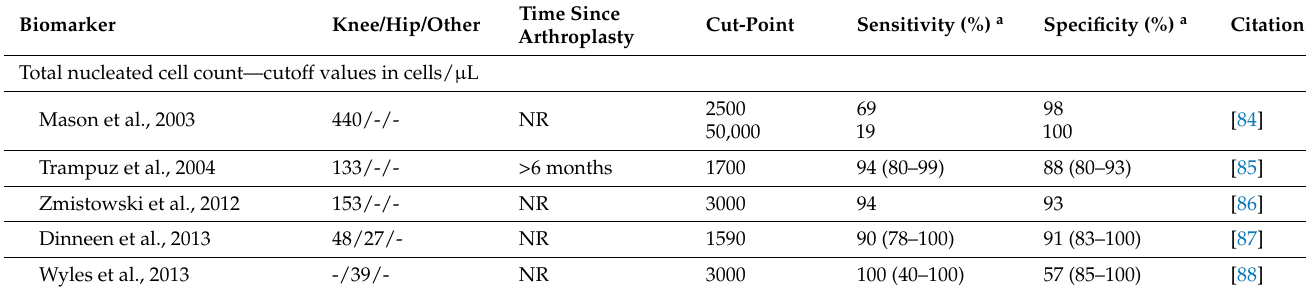
Table 1. Sensitivity and specificity of synovial fluid total nucleated cell count and polymorphonuclear percentage for periprosthetic joint infection